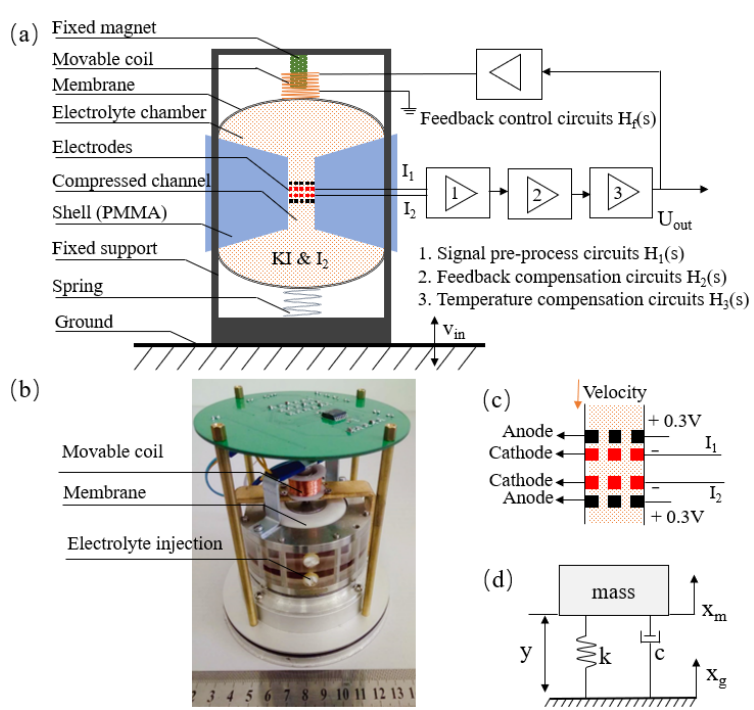
Figure 1. ( a ) The structure diagram of the electrochemical seismic sensor. The electrolyte that serves as the inertial mass transfer the outside vibration to the flow velocity, and then the change of ion concentration near the electrodes transfers to currents by the electrochemical reactions. ( b ) The prototypes of uniaxial electrochemical seismic sensors. ( c ) The sensitive electrodes of electrochemical seismic sensor, placed by ACCA at the center of compressed channel. ( d ) The diagram of the typical second-order inertial damping system.